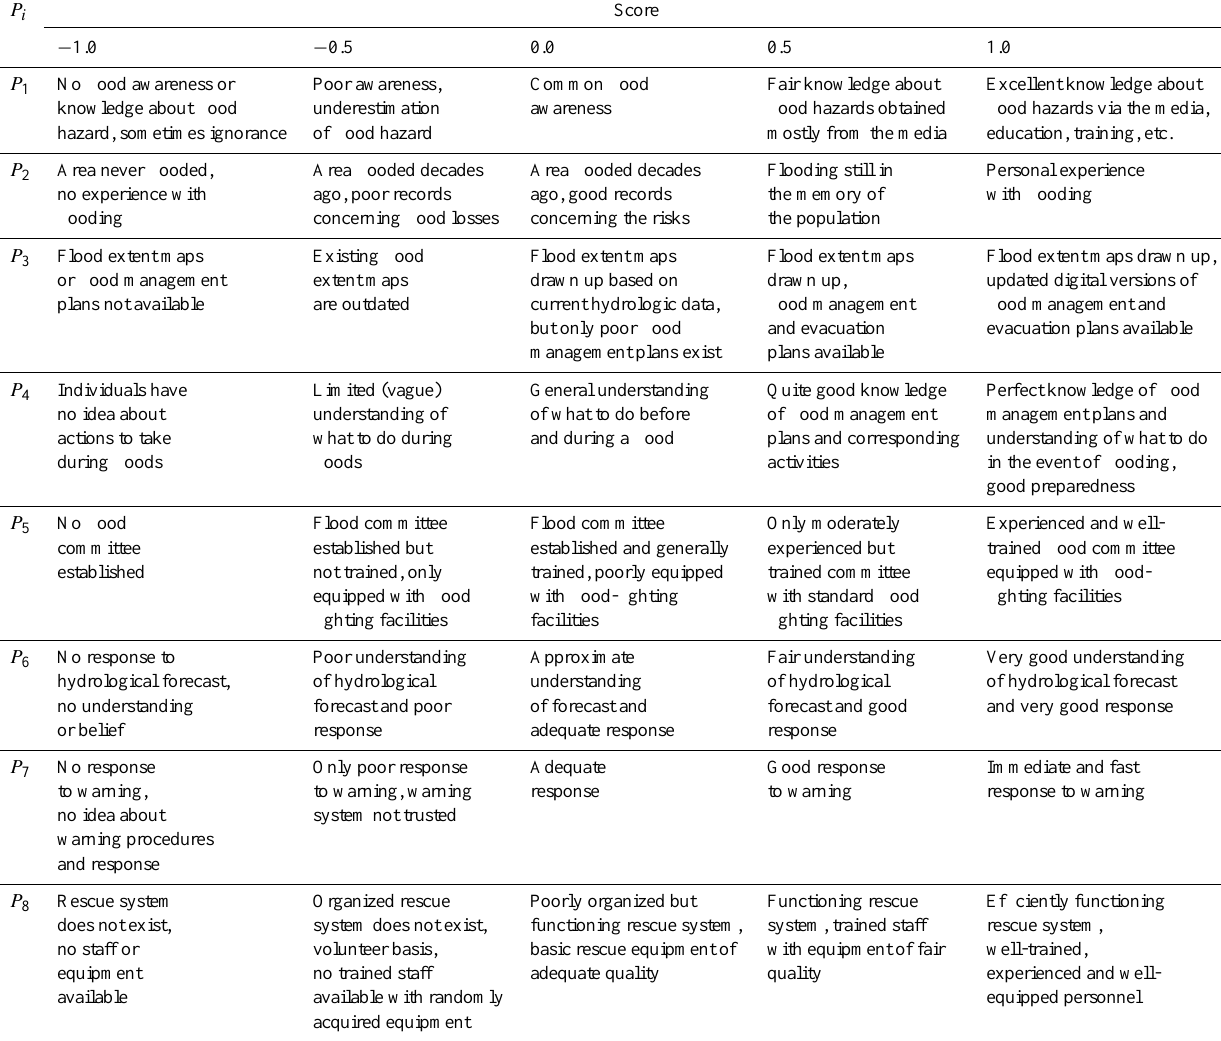
Table 6. Guidance on the scoring of general preparedness items P i . P i Score −